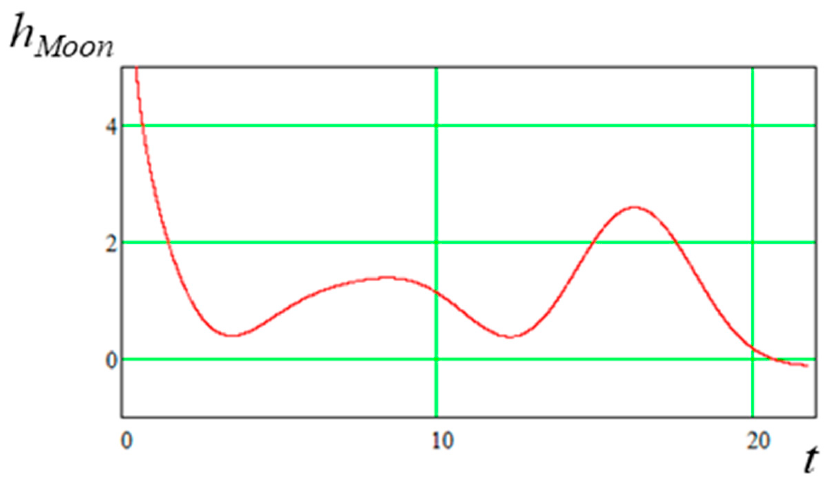
Figure 14. Dependence of the change in the selenocentric energy of the spacecraft along the transfer trajectory; it is clearly seen that at the moment of approaching the SC to the vicinity of the Moon, the values of the latter pass into the negative region, thereby ensuring the possibility of realizing the spacecraft’s entry into a closed selenocentric